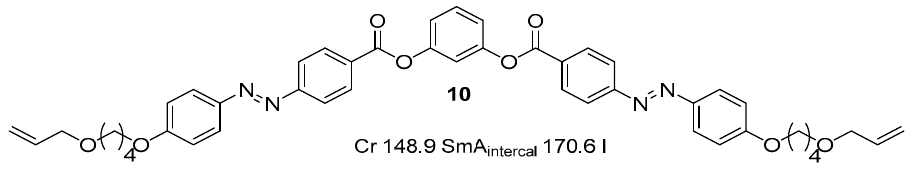
Table 1. Phase transition of homologues of compounds 11 .